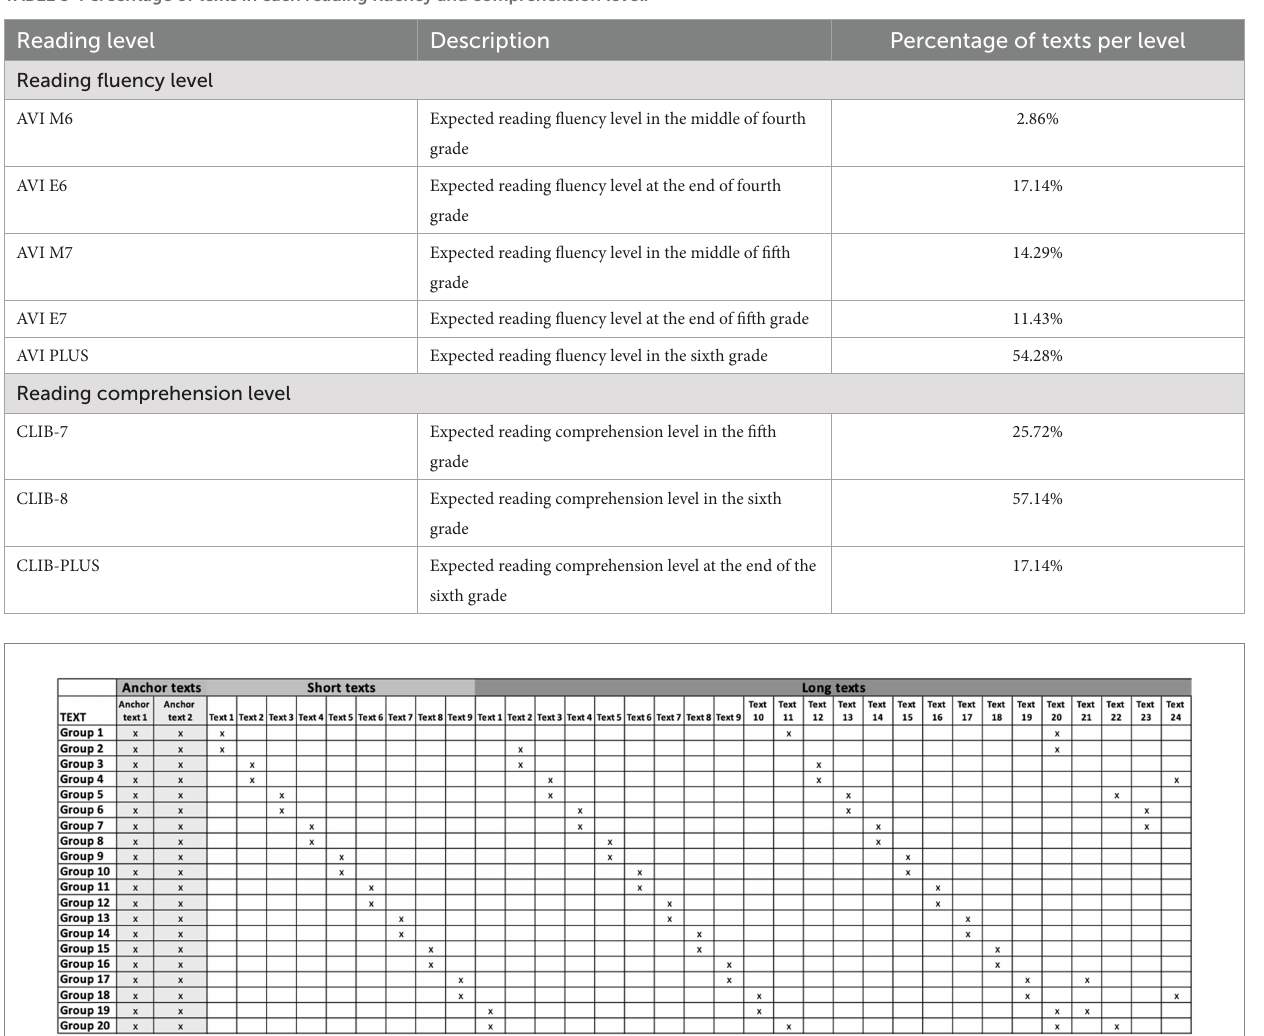
FIGURE 1 Stepwise system of the original test pool. For example, group 1 completed both anchor texts, short text 1, long texts 11 and 20 with the accompanying MC test items. Group 2 overlapped with group 1 for the anchor texts, short text 1 and long text 20. Group 2 differed from group 1 in completing long text 2 instead of long text